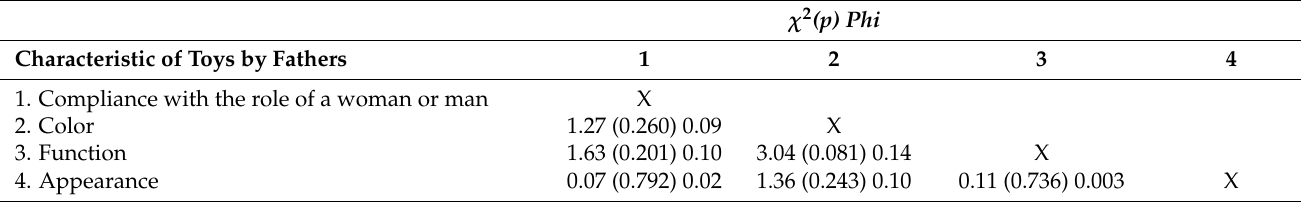
Table 6. Characteristics of toys affecting their categorization for girls or for boys—differences in fathers’ opinions.